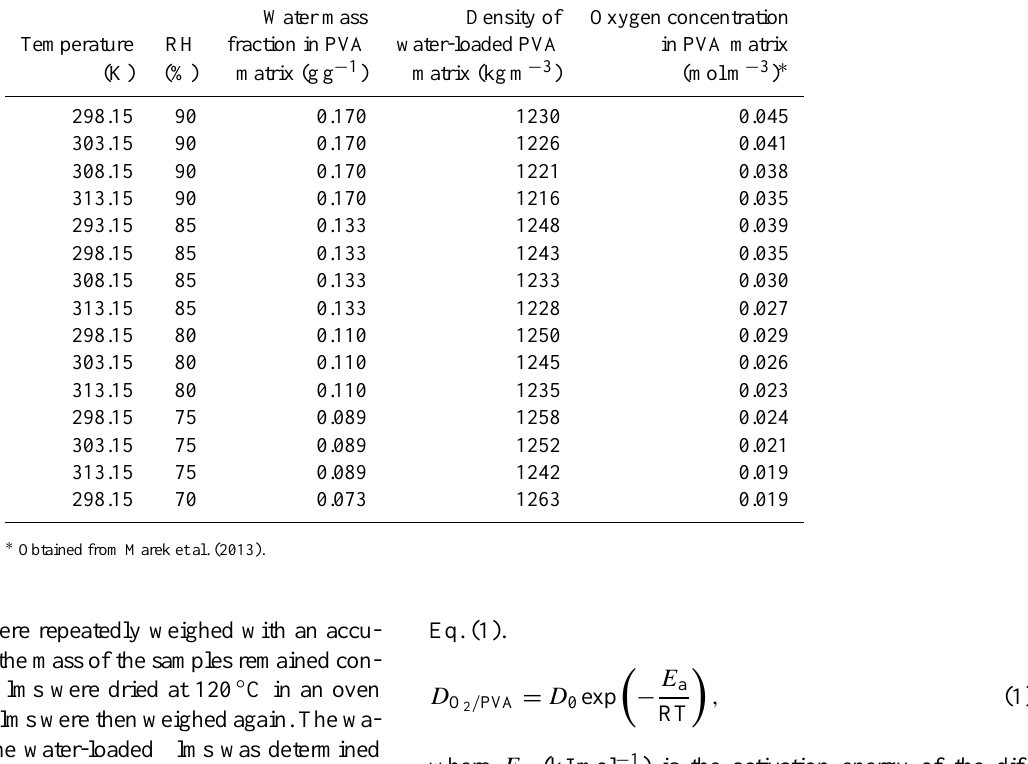
Table 1. Correlation between the temperature, RH and water mass fraction in the PVA matrix for conditions investigated in this work. The density as well as oxygen solubility of the resulting water-loaded PVA films at these conditions are also